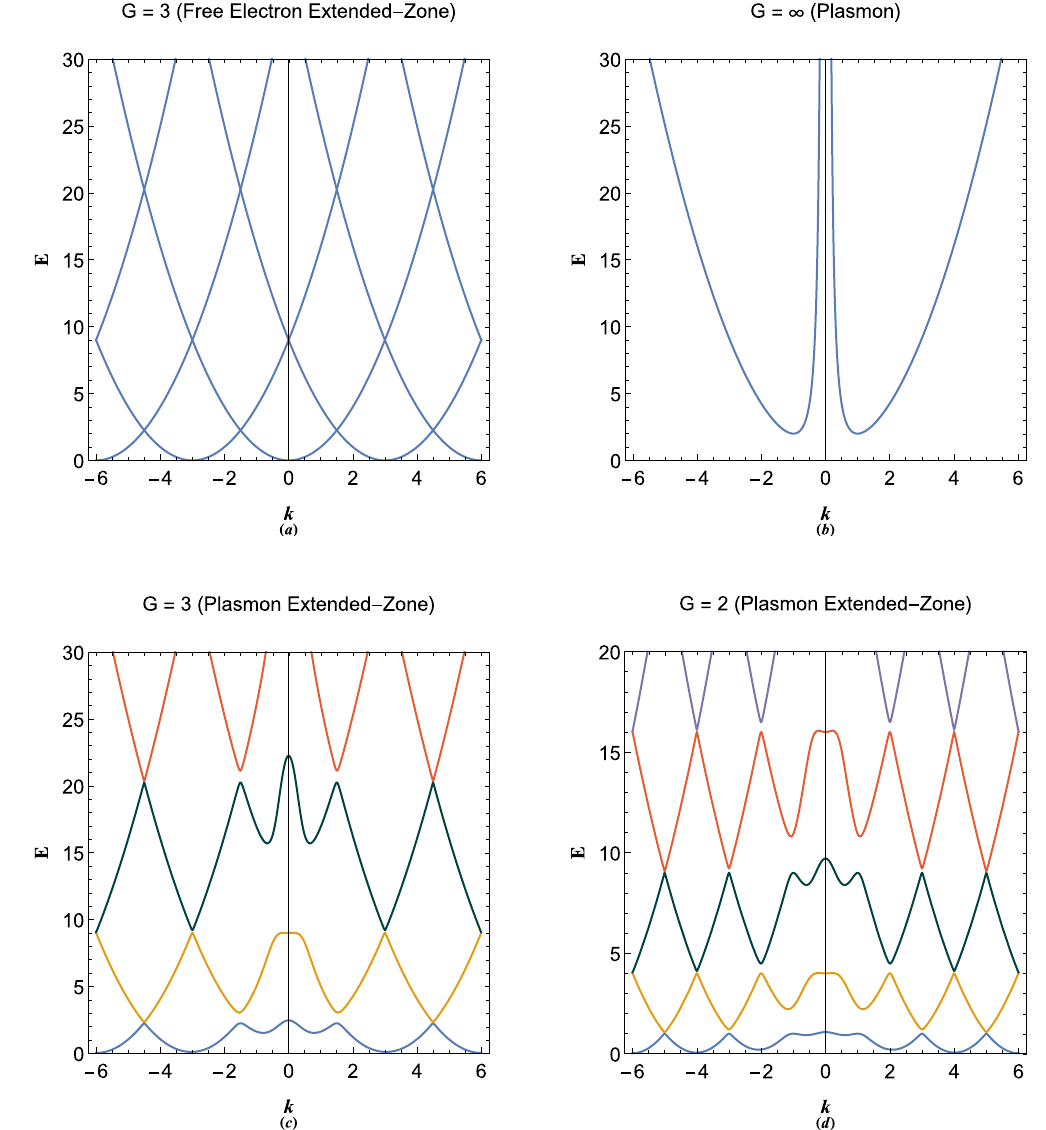
Figure 7. ( a ) The electronic extended-zone energy band structure in free electron model. ( b ) The plasmon excitation band in the limit G . ( c ) The extended-zone electronic band structure of plasmonic crystal with → ∞ 3 . ( d ) The extended-zone electronic band structure of plasmonic crystal with G G =